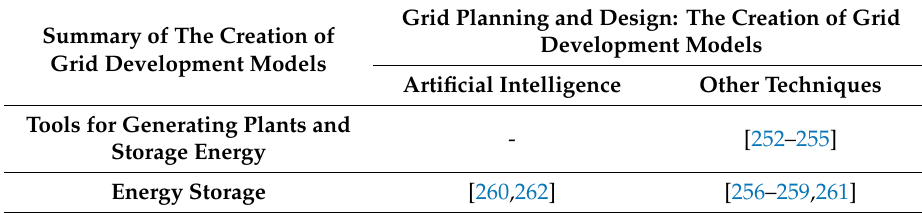
Table 11. Summary of The Creation of Grid development